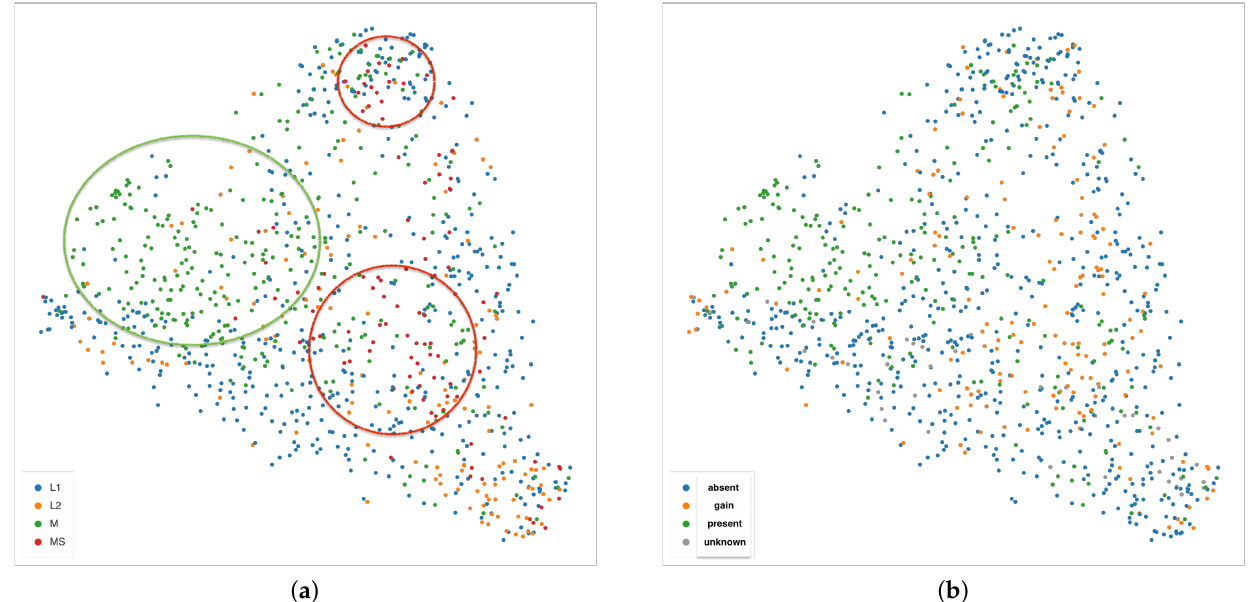
Figure 15. UMAP 2-dimensional embedding on the second layer of the decoder path of the EUNet, with Euclidean metric, minimum distance 0.02 and 15 neighbours. ( a ) Color indicates INRGSS. The red and green ovals mark the plot areas enclosing the majority of NB patients of stage MS and M, respectively. ( b ) Color indicates MYCN